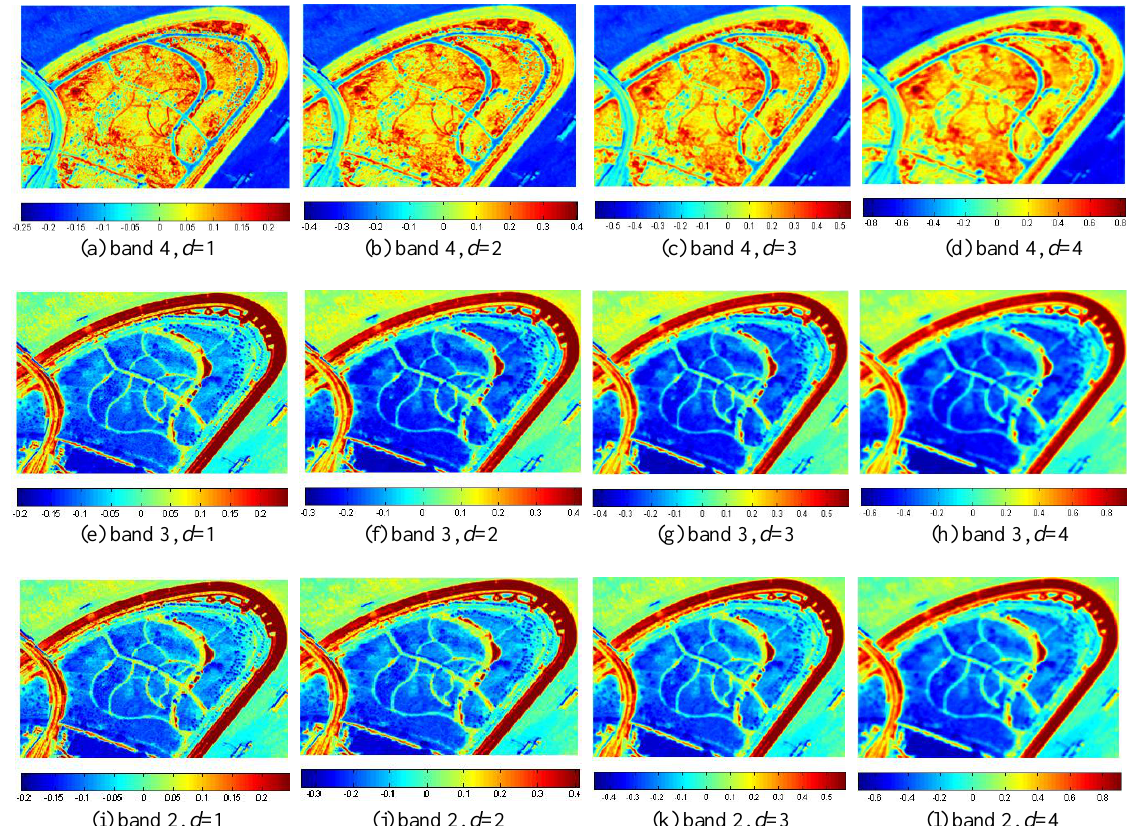
Figure 5. Spatial autocorrelation images of different spectral bands with different window parameter d